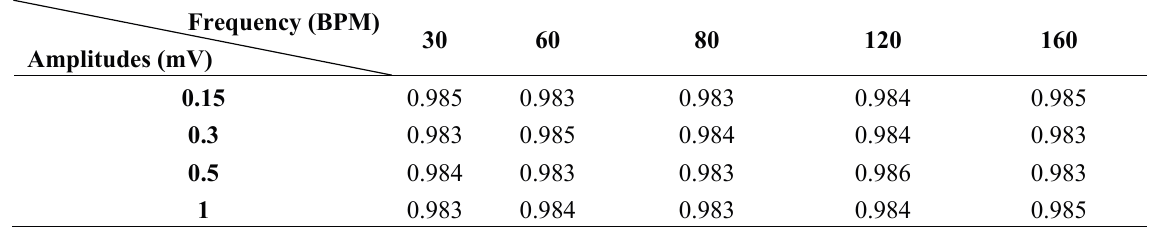
Table 4. Average signal cross correlation between ECG generator device and the proposed sensor.